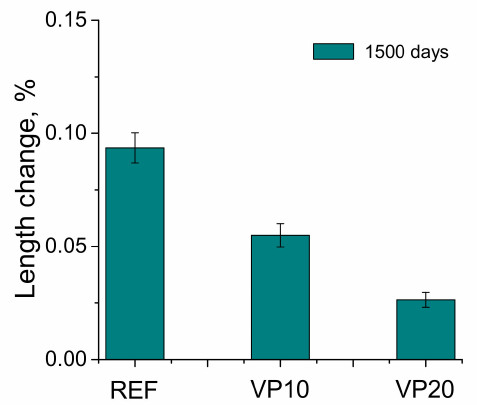
Figure 12. Length change noted for the mortar series analyzed after 1500 hardening